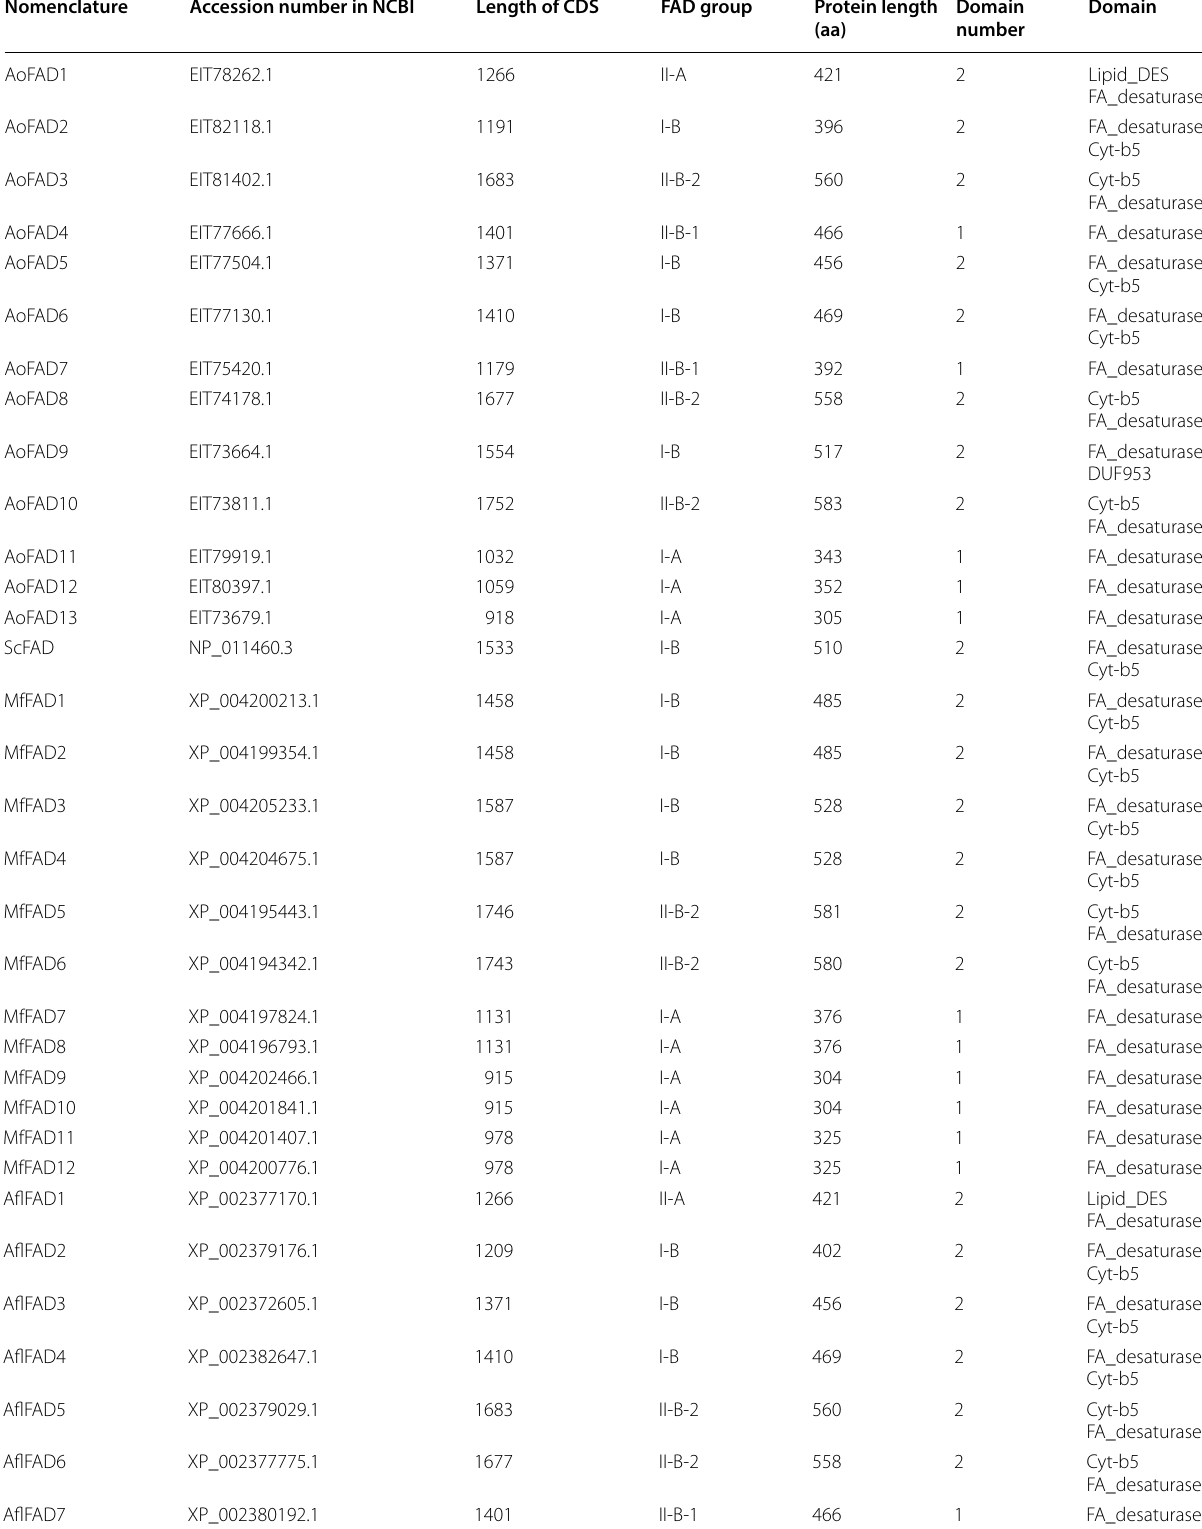
Table 1 The FAD family members in the six